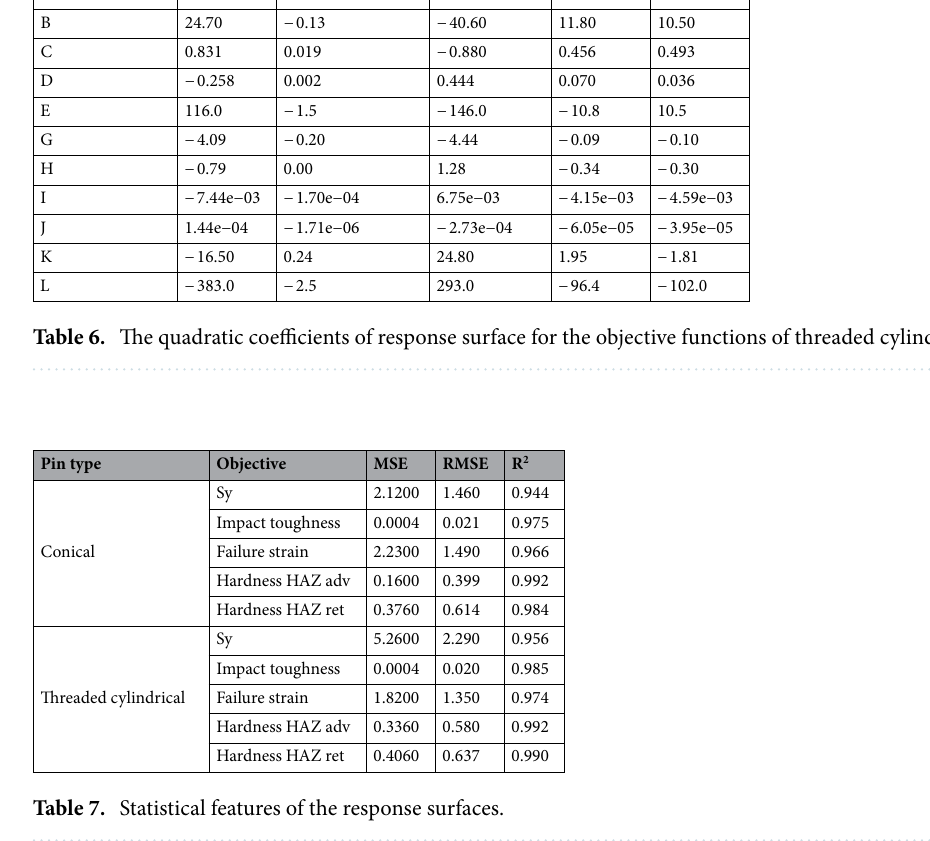
Obj.\coefficient